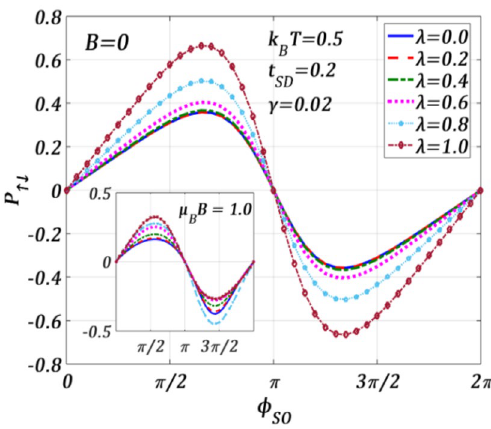
0.5 t SD 0.2, γ 0.02, eV b = = =